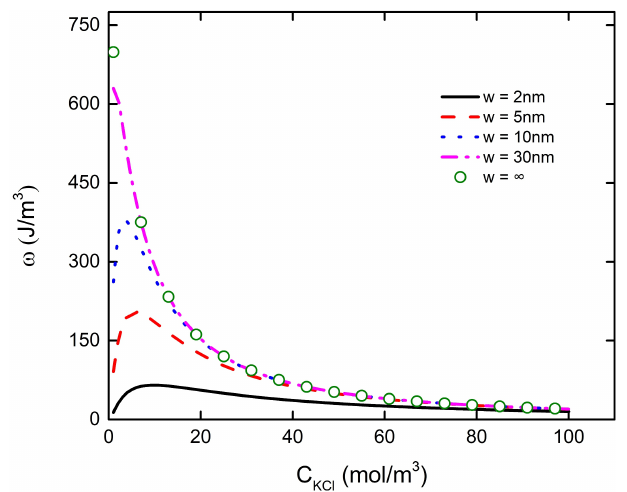
Figure 10. The curve of the electric field energy density in the PE brush layer at the bottom of the nanoparticle with the concentration of the background salt solution at di ff erent distances between the particle and the plate at pH = 7.